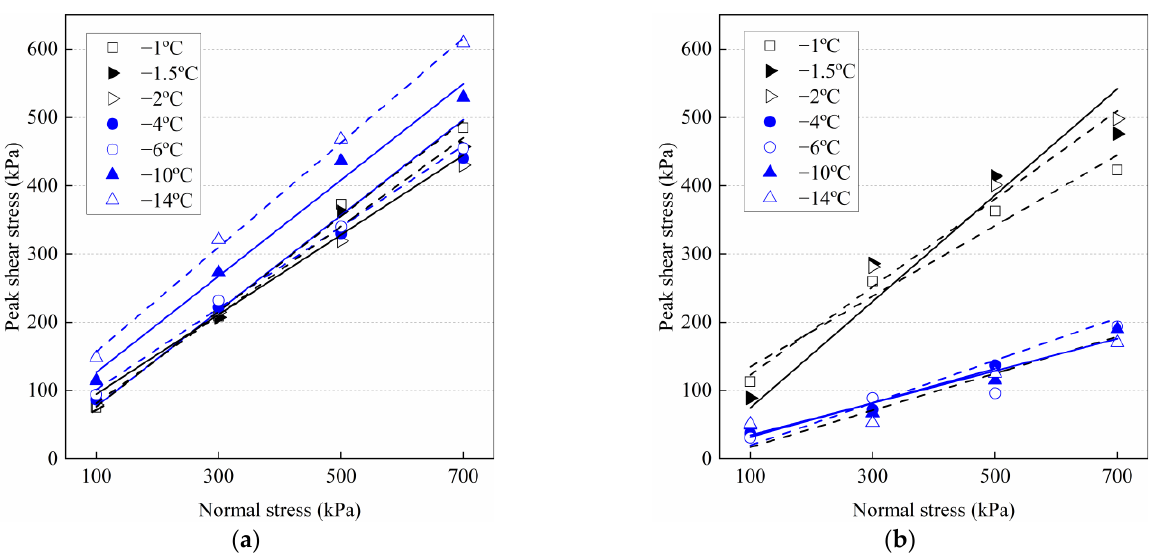
Figure 9. Variation of the peak shear stress with the different number of cycles at various temperatures. ( a ) N = 1; ( b ) N = 30. ( a ) N = 1; ( b ) N =